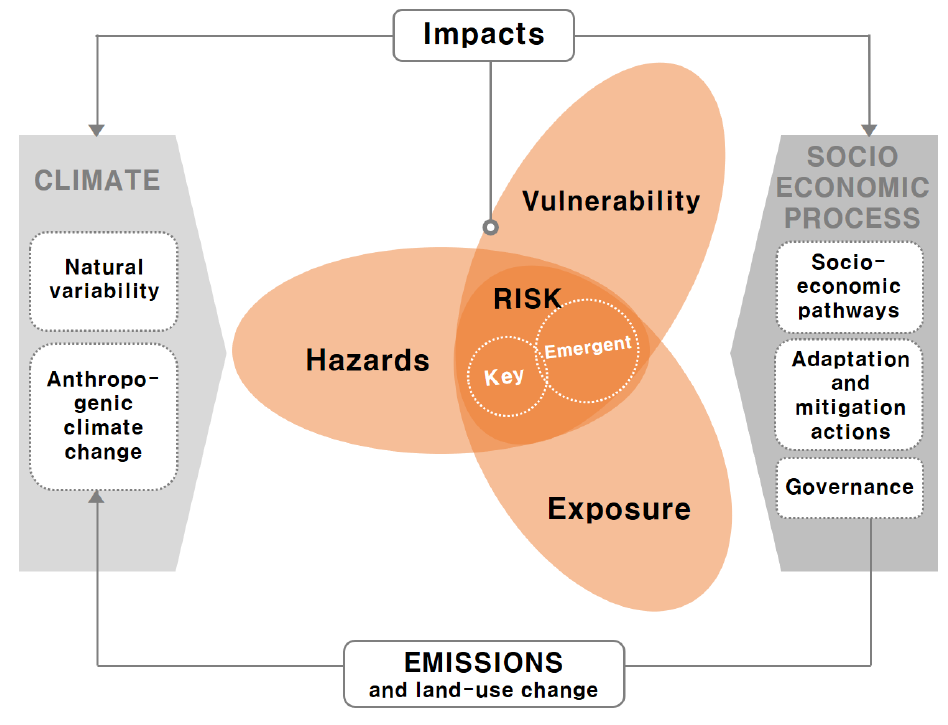
Figure 4. Flood risk concept [29].